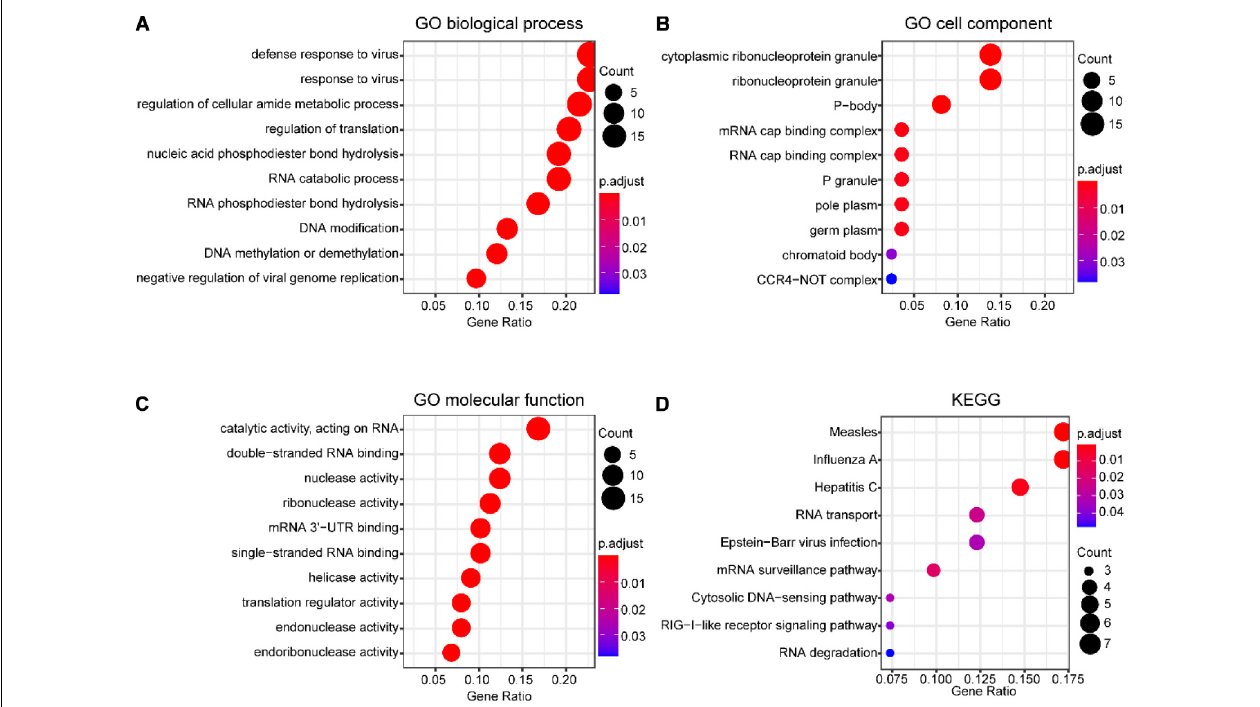
FIGURE 2 | Functional enrichment analysis of DERBPs in SCCHN of the TCGA data set. (A–C) The top 10 enriched GO terms of biological process (A) , cell component (B) , and molecular function (C) for DEUPSGs shown using a scatter diagram. (D) The enriched KEGG pathways also demonstrated using a scatter diagram. GO, gene ontology; KEGG, Kyoto Encyclopedia of Genes and